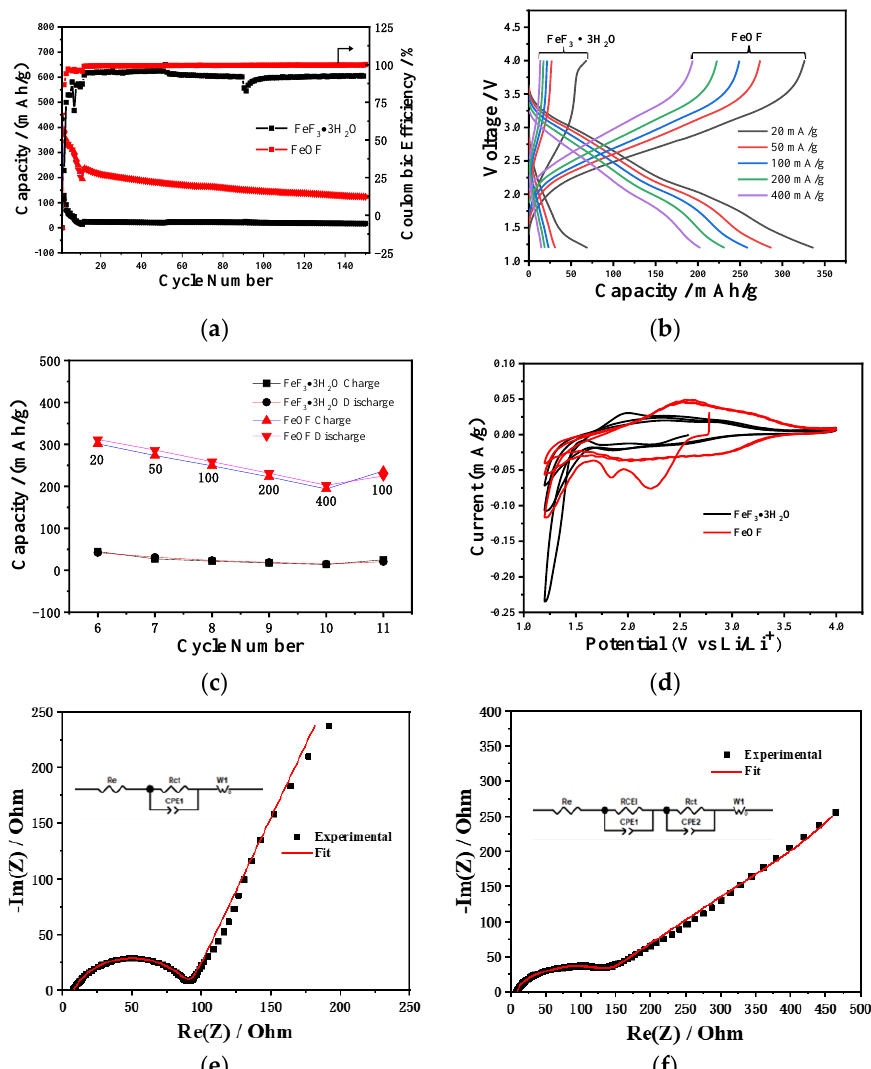
Figure 4. ( a ) Coulombic efficiency and the cycling performance. ( b ) The charge/discharge profiles at different current rates. ( c ) Charge/discharge capacities at different current rates. ( d ) CV curves at 1.2–4.0 V. ( e ) EIS curves of the FeOF electrodes for LIBs before cycling. ( f ) EIS curves of the FeOF electrodes for LIBs after cycling. The equivalent circuit used for fitting is shown in the inset. Table 2. Comparisons of the electrochemical performances of the present FeOF with related repre- sentative FeOF cathode materials for LIBs reported in the literature.